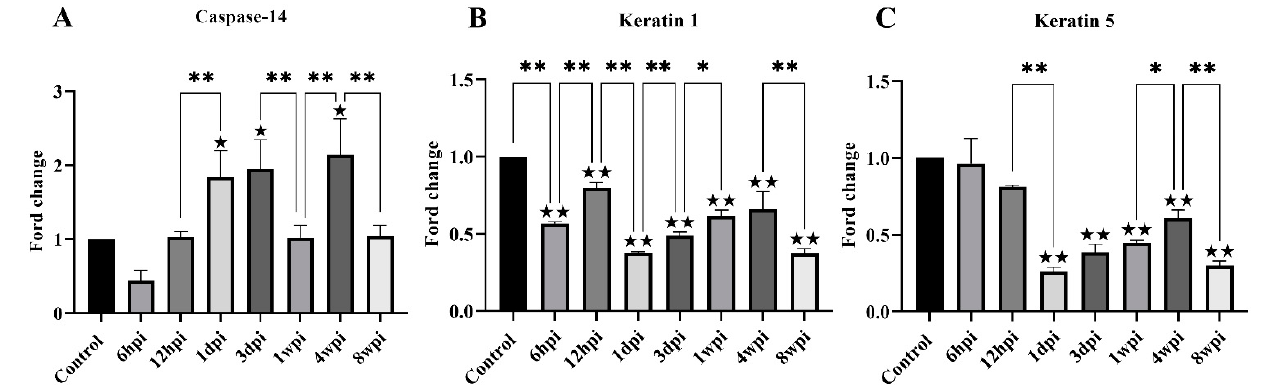
Figure 7. The level of mRNA expression of genes related to skin keratinization. (A): Caspase-14, (B): Keratin 1, (C): Keratin 5. Data are represented as the mean ± standard deviation (M ± SD). A one-way ANOVA analysis was used to analyze the variances between the groups. The horizontal line indicates a significant adjacent pairwise group difference (* p < 0.05 and ** p < 0.01). ★ on the bar represents a significant difference between the specific experimental group and the control group ( ★ p < 0.05 and ★★ p < 0.01).